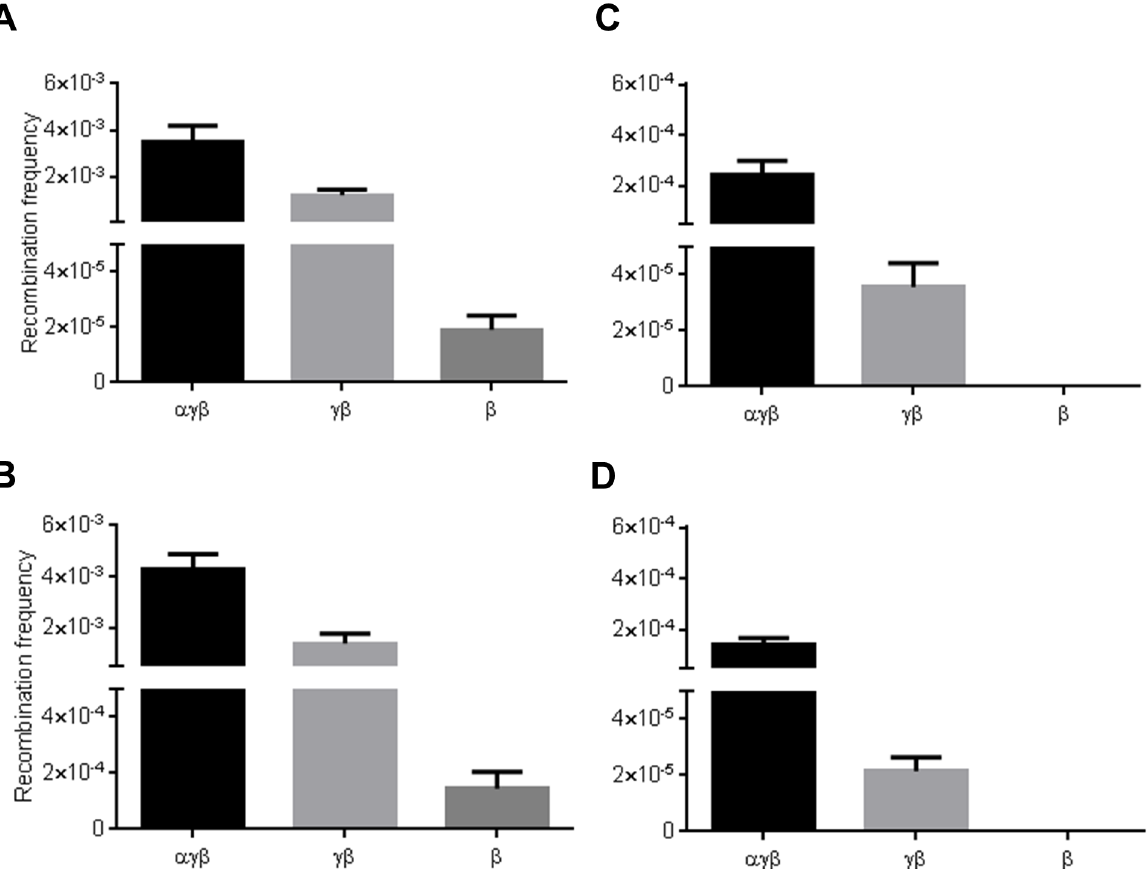
Fig 5. Requirement of different Red proteins for singleplex and multiplex recombination. (A) Insertion. A Gentamicin resistance cassette was inserted at a site of the P2rx1 gene. (B) Gap repair. A p15A zeo subcloning plasmid was used to subclone a region of the P2rx1 gene. (C) Multiplex insertion. Two different Gentamicin and Zeocin resistance cassettes were inserted at two different sites of the P2rx1 gene. (D) SPI assay. The p15A zeo subcloning plasmid was used together with the Gentamicin resistance cassette. Recombination assays were performed using lagging strand protected cassettes and with expression of different Red proteins. Values represent average; error bars indicate standard error of mean ( n = 3 for A, B and D, n = 4 for C).